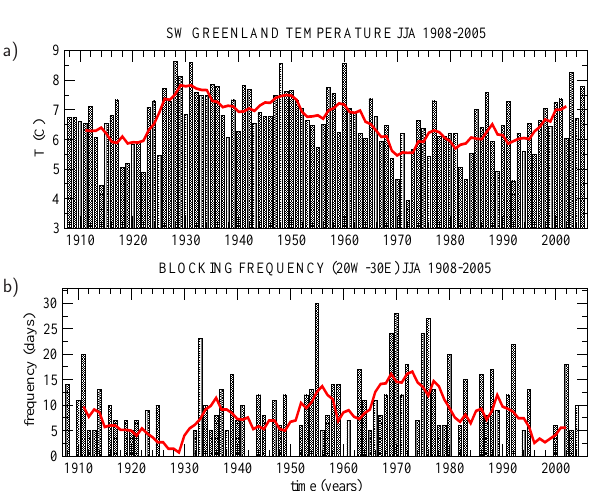
Fig. 10. Frequency composites of blocked days for warm (red) and cold (blue) summers in southwestern Greenland.